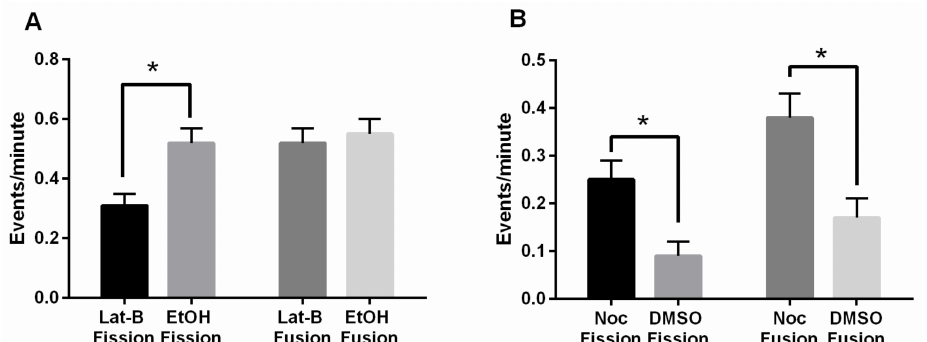
Figure 4. Fission and fusion in treated cells overexpressing FszB-GFP. ( A ) Treatment with Lat-B in comparison to EtOH decreases fission events by 68% ( p = 0.0240), there is no di ff erence in fusion. ( B ) Noc treatment increases fission, 64%, and fusion, 55%, in comparison to the vehicle ( p = 0.0150, 0.0002 respectively). These rates are similar to untreated cells overexpressing FszB-GFP. n = 30 cells, * indicates significance.